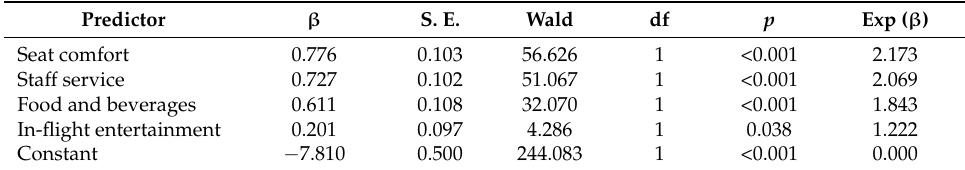
Table 4. Binominal logistic regression results.